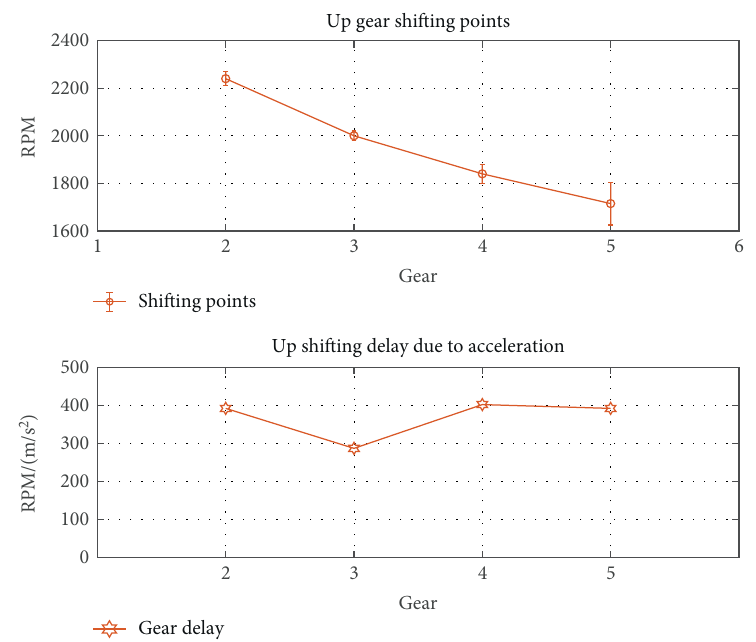
Figure 9: Estimated gear shifting points ( 𝑅𝑃𝑀 𝑈𝑃 g ) and how shifting points are delayed by acceleration ( Δ𝑅𝑃𝑀 𝑈𝑃 g ) based on the field trials data for a Volvo V70 (6 gears diesel). Lack of data gives no estimation for 1 st gear. The error bars show 95% confidence